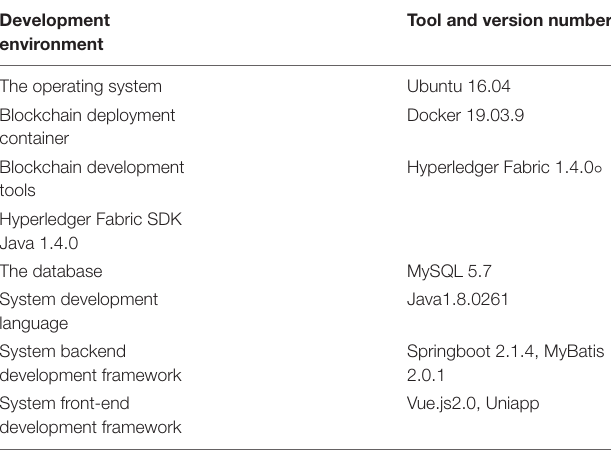
TABLE 1 | System development environment